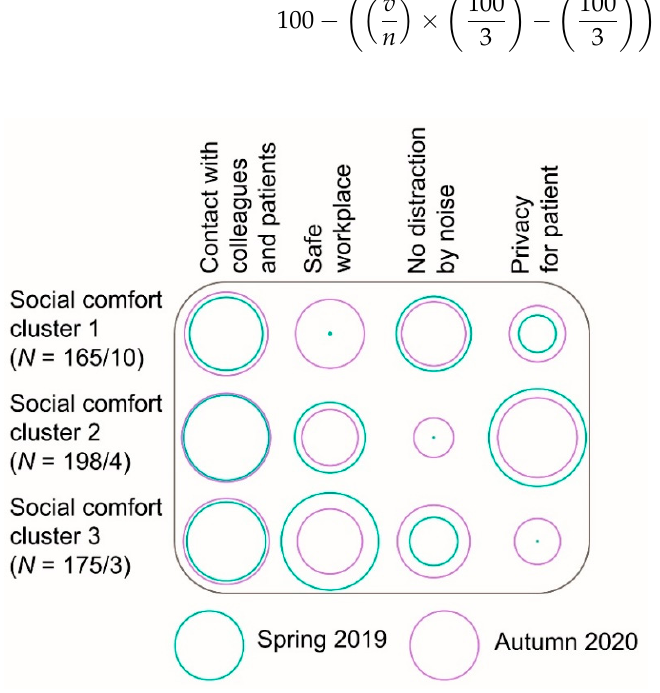
Figure 8. Proportion of preferences selected per social comfort cluster in 2019 and average rating of preferences in 2020. preferences in